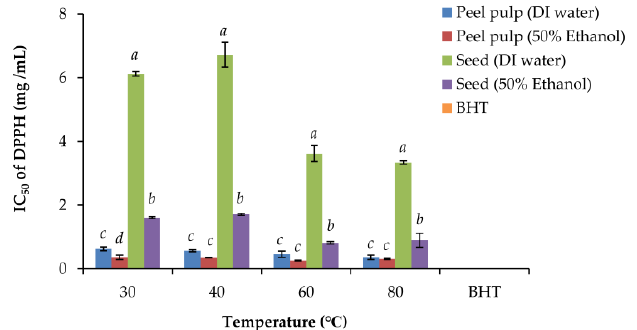
Figure 3. DPPH IC 50 of jujube peel pulp and seeds extracted using DI water and 50% ethanol at di ff erent temperatures. The error bar represents the standard error of the mean. Temperatures in the histogram with the same letter were not significantly di ff erent at the 5% level, according to the results of the LSD